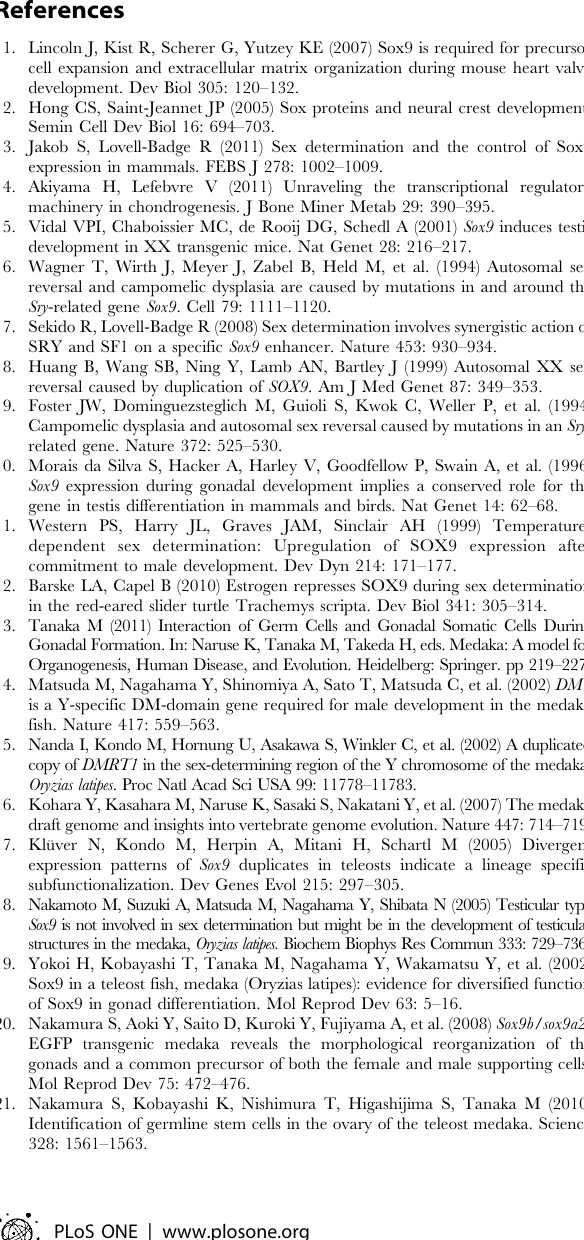
Figure S4 Ventral images of medaka wild-type and mutant gonads at different stages. (A–C) Ventral views of medaka gonads at the stage of gonadal primodium, stage 34 (A), the stage of female-specific increase of germ cells, stage 39 (B) and the stage of apparent sexual dimorphism of gonads, 10 dph